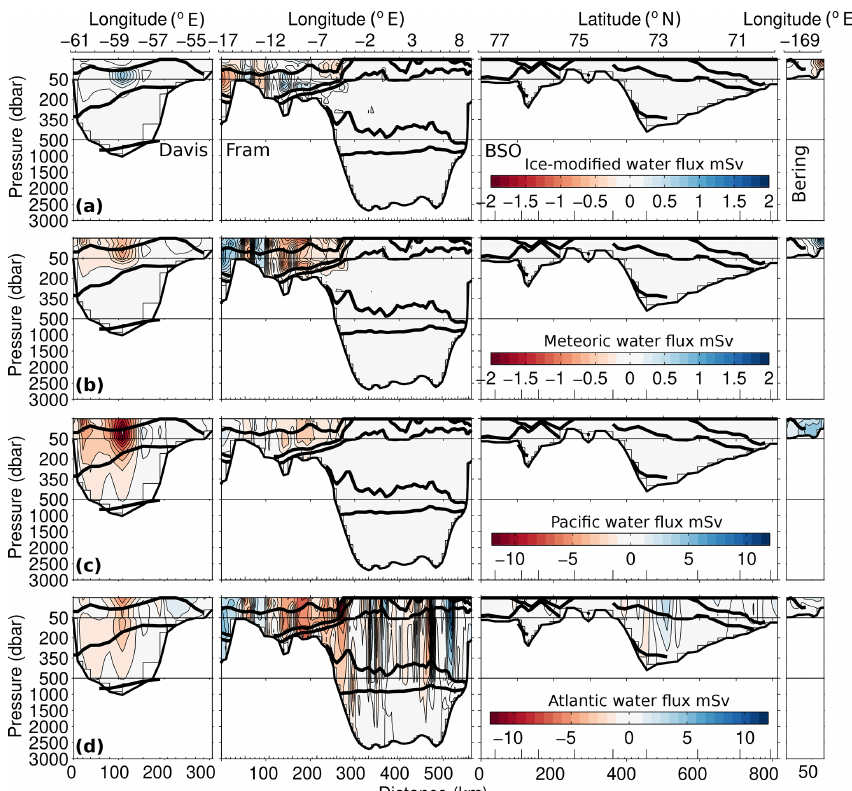
Figure 10. Sections of ice-modified water flux (a) , meteoric water flux (b) , Pacific water flux (c) and Atlantic water flux (d) , for the 4EM+ model (mSv), clockwise around the four gateways from Davis Strait to Bering Strait. Solid black lines indicate the isopycnal surfaces separating the main Arctic water masses as described in Tsubouchi et al. (2012). End members used were the mean of the literature values (see Tables 2 and 3). Note different colour scales for each panel. Positive values indicate flux into the Arctic. Table 8. Mean volume fluxes (Sv ± standard deviation) for the four-end-member (4EM+) model. Positive values indicate fluxes into the Arctic. Values of solid freshwater flux from Tsubouchi et al. (2012). Atlantic Pacific Met. Ice melt Sum